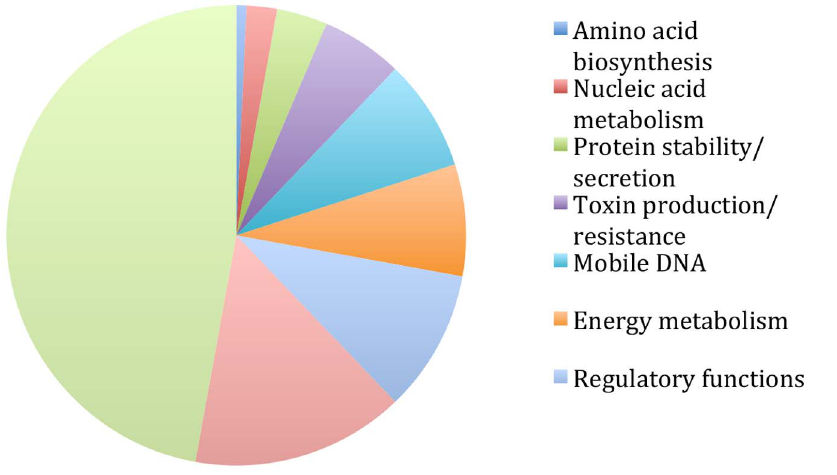
Figure 6. The functional role classification for genes in the 165 kb duplication. The functional roles for the 140 genes in the 165 kb duplication were based on the J. Craig Venter Institute-Comprehensive Microbial Resource (JCVI-CMR) Cellular Role Category annotation [48]. The JCVI-CMR Cellular Role Category annotation for each gene in the duplication is shown in Table S2.